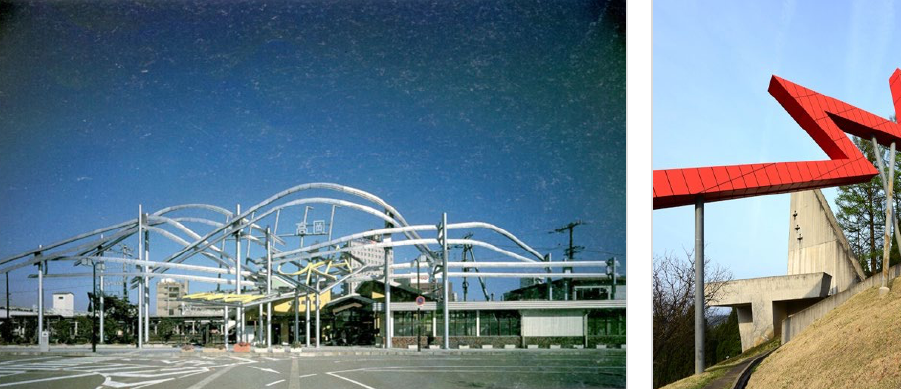
Figure 30 Sculpture by Spanish architect Enric Millares was removed in 2014.